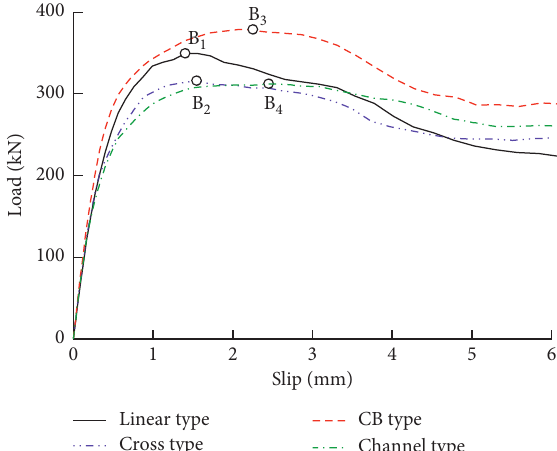
Figure 11: Load-slip curves of shear connectors.